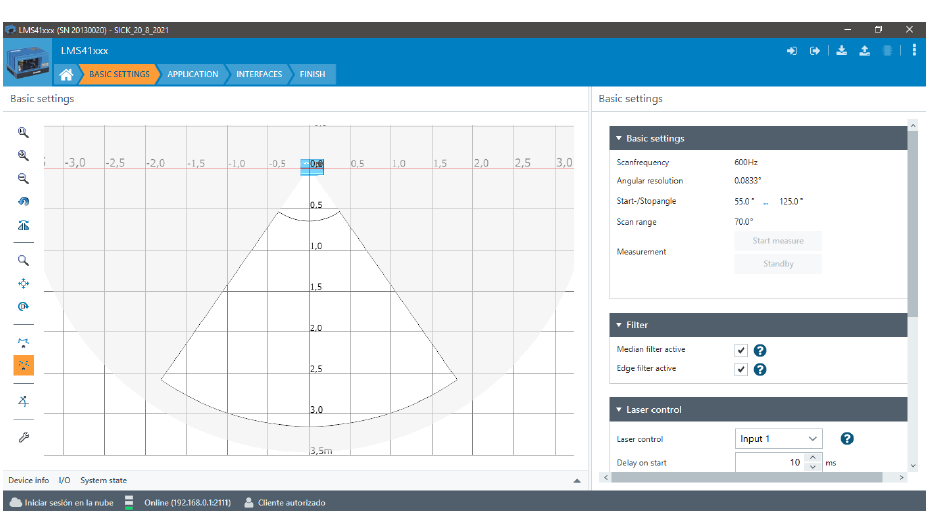
Figure 2. LiDAR configuration in the SOPAS ET software.